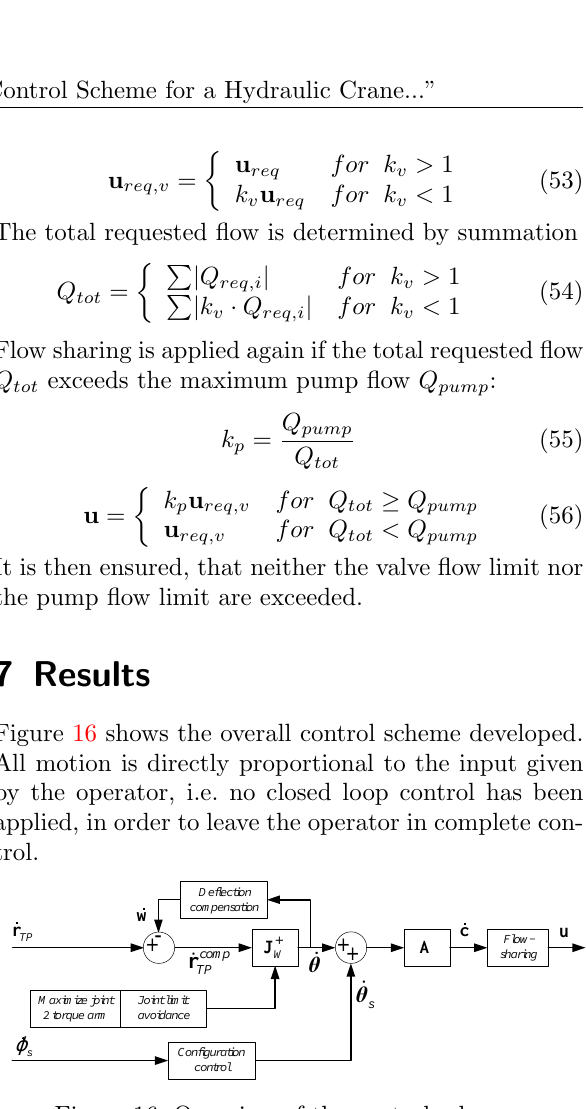
Figure 16: Overview of the control